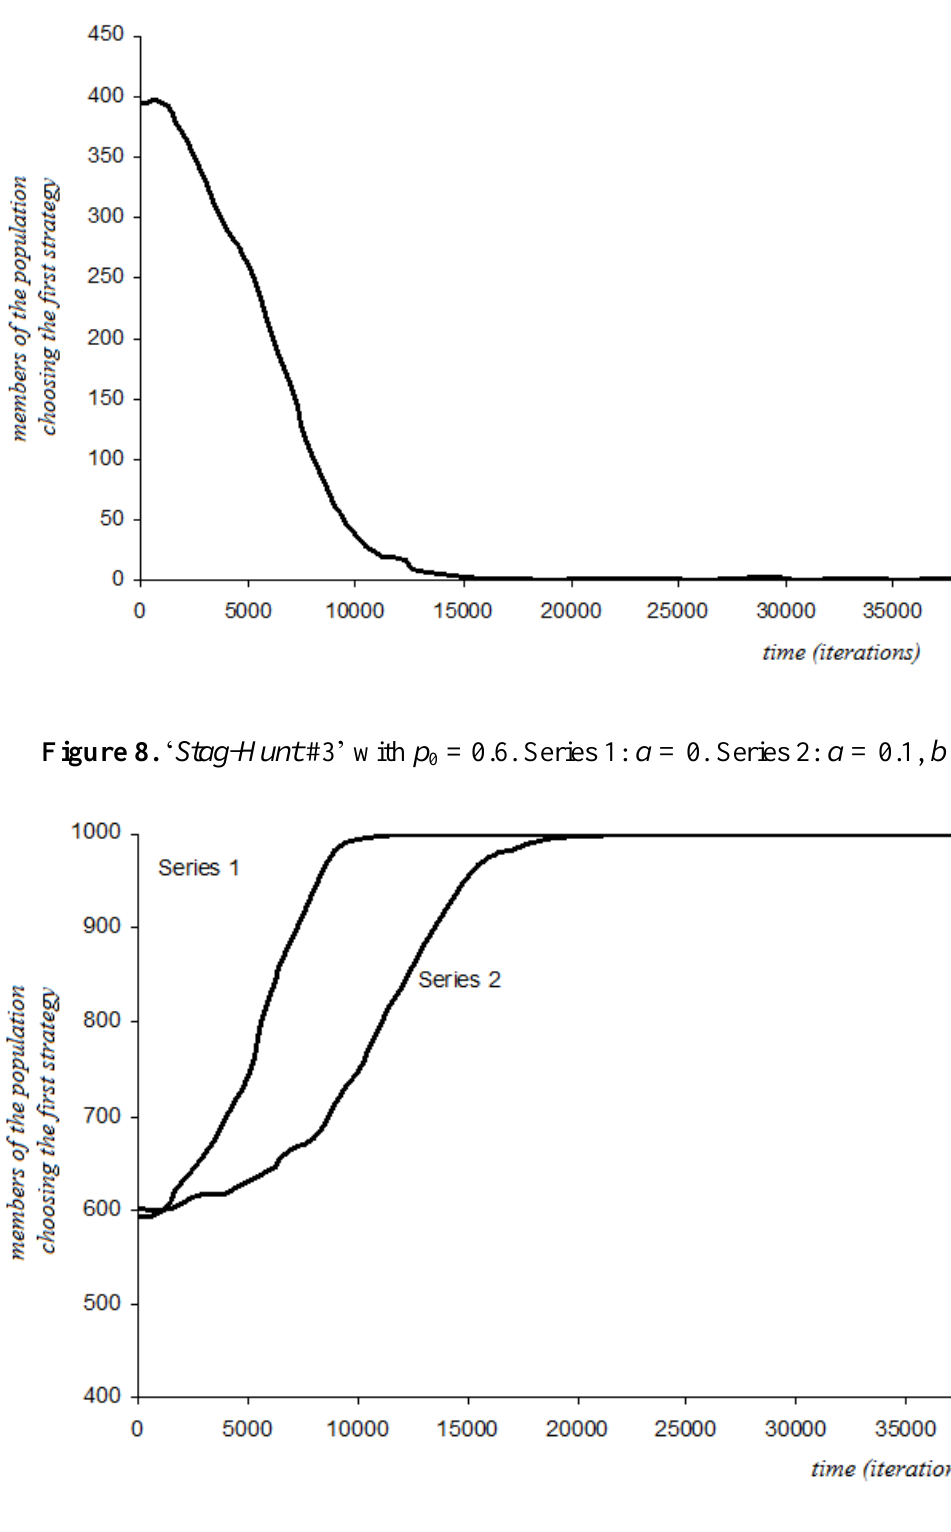
Figure 7. ‘ Stag-Hunt ’ with p